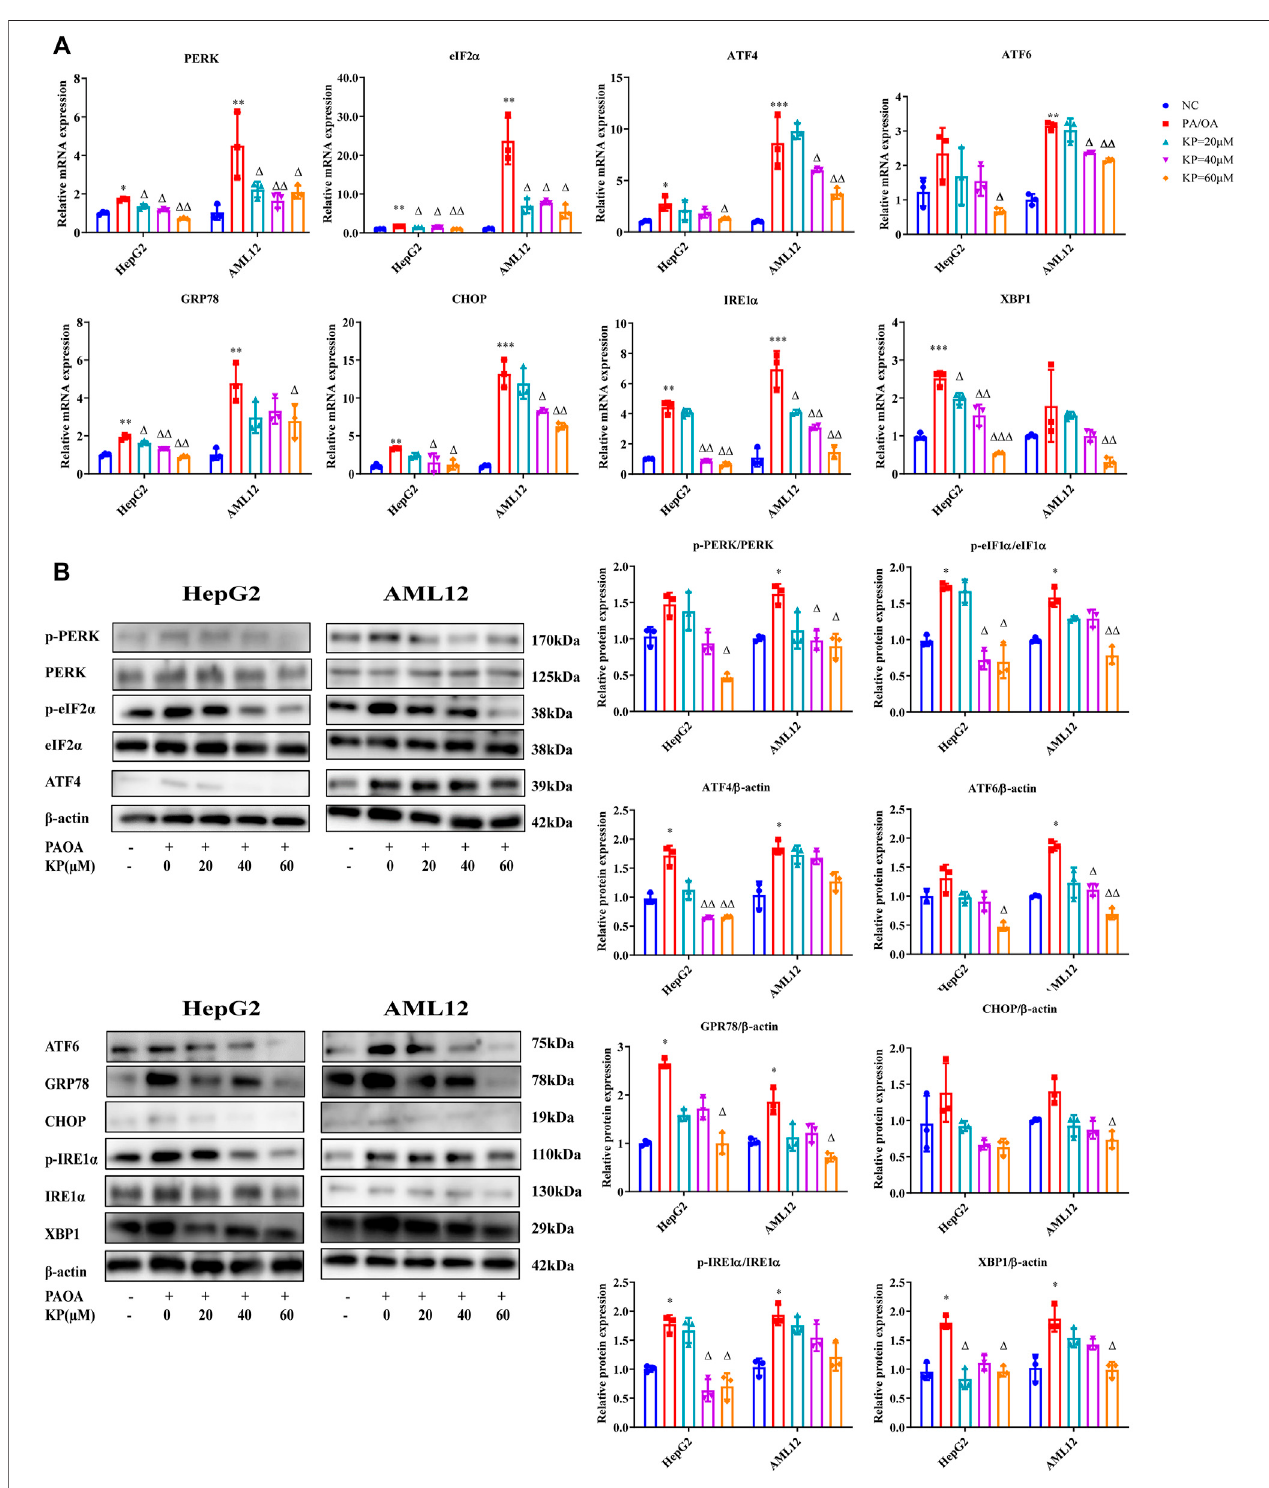
FIGURE 6 | KP regulated the mRNA and protein expression of factors related to ERS in vitro . (A) : mRNA Expression in HepG2 and AML12 cells; (B) : protein Expression in HepG2 and AML12 cells. NC: Normal control group, PA/OA: PA/OA group, KP (cid:2) 20 µM: KP low concentration group, KP (cid:2) 40 µM: KP medium concentration group, KP (cid:2) 60 µM: KP high concentration group. Quanti fi cation of mRNA and protein level expression was normalized to β -actin levels, except protein phosphorylationlevelexpression ofPERK, eIF2 α ,IRE1 α expression wasnormalized totheirprototypes. Compared with groupNC, *, p < 0.05, **, p < 0.01, ***, p < 0.001; Compared with group PA/OA, △ , p < 0.05, △△ , p < 0.01.